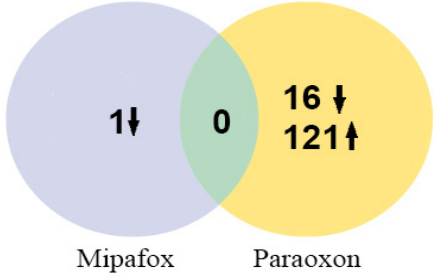
Figure 4. Venn diagram of the genes with altered expressions after exposure to